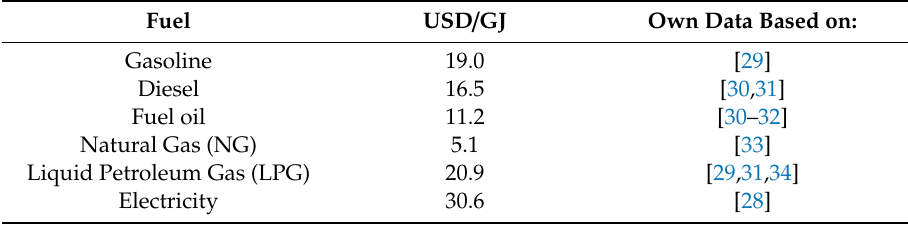
Table 2. Levelized price of fuels used in Transport